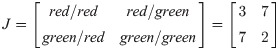
The MD in four chemotactic scenarios simulated using the Cellular Potts Model.A: Cells (green) forming the MD are repelled by the chemotactic agent produced by themselves. B: Cells (green) forming the MD are attracted by the chemotactic agent produced by surrounding (red) cells. C: Cells (red) surrounding the MD are attracted by the chemotactic agent produced by cells (green) forming the MD. D: Cells (red) surrounding the MD are repelled by the chemotactic agent produced by themselves. Locations of the MD at three consequent instances of time are shown for each scenario. Concentration of chemotactic agent is represented by shadows of grey from black (highest concentration) to white (lowest concentration). To maintain the direction of motion (to the right) the initial asymmetry was set in the following manner: green cells were initially set close to the left border; during initial 4000 time units the chemotaxis was turned off giving time for the concentration field to establish; then the concentration field was shifted 10 grid points left and chemotaxis was turned on. From this moment (T = 0) the domain was moving due to chemotaxis. The medium contains 31x55 cells, green domain– 9 cells, average cell contains 49 grids. Model parameters describing the dynamics of morphogen: D = 0.5, k1
= 2.5*10−4, k2
= 2*k1; β = -8700, both, time and space, steps are set to one. Other model parameters in CPM (for the explanation of these parameters see [9]) elasticity of cells in CPM, λ = 0.6; Boltzmann temperature, T = 5.0; adhesiveness matrix (cell_type1/cell_type2):J=[red/redred/greengreen/redgreen/green]=[3772].